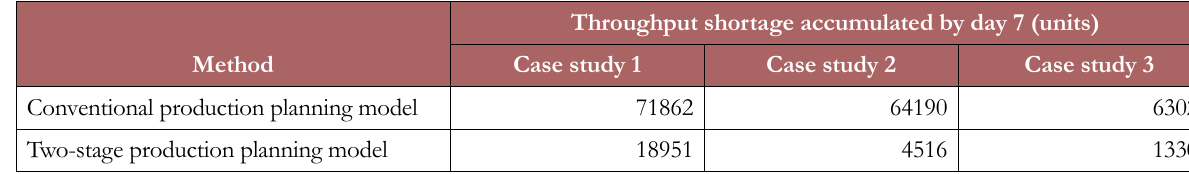
Table 5. Summary of losses data for Each